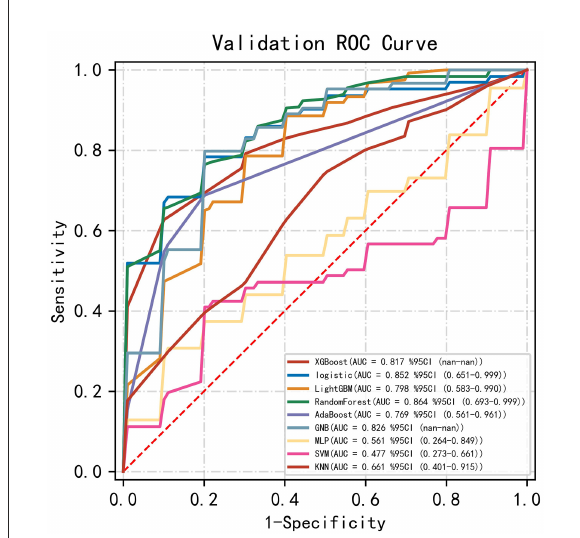
FIGURE4 Comparisons of different machine learning models in the area under the receiver operating characteristic curve (AUC) in the validating set. RF, random forest; GNB, Gaussian NB; MLP, multi-layer perceptron neural network; SVM, support vector machine; KNN, k-nearest